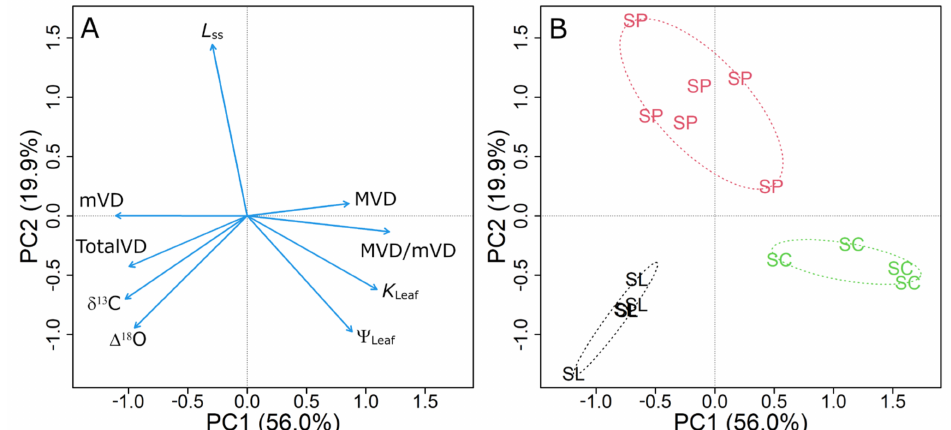
Figure 5. Principal component analysis (PCA) for leaf hydraulics, isotopes and venation variables among the three species here studied. The variable loading plot ( A ) shows the variables as blue arrows: Ψ Leaf , leaf water potential; K Leaf , leaf hydraulic conductance; MVD, mVD and MVD/mVD, major, minor vein density and major/minor vein ratio; L ss , mean effective path length; δ 13 C, leaf carbon isotope composition; ∆ 18 O, isotopic enrichment of leaf water. The scores plot ( B ) shows the score of each replicate along the PCA axis, indicating the species grouping: S. lycopersicum (SL), S. peruvianum (SP) and S. chilense (SC) and their respective ellipsoid